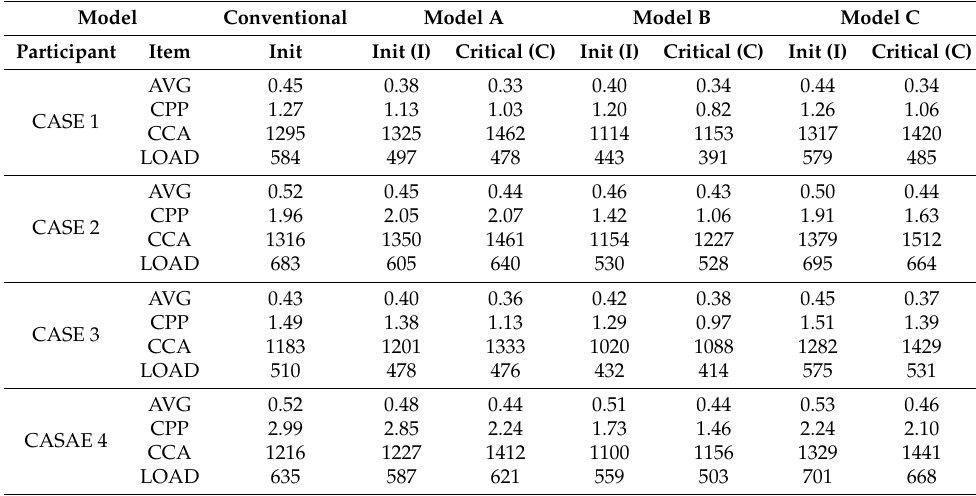
Figure 19. Measured data: change of pressure distribution for each sitting posture. Table 4. Reference list for the